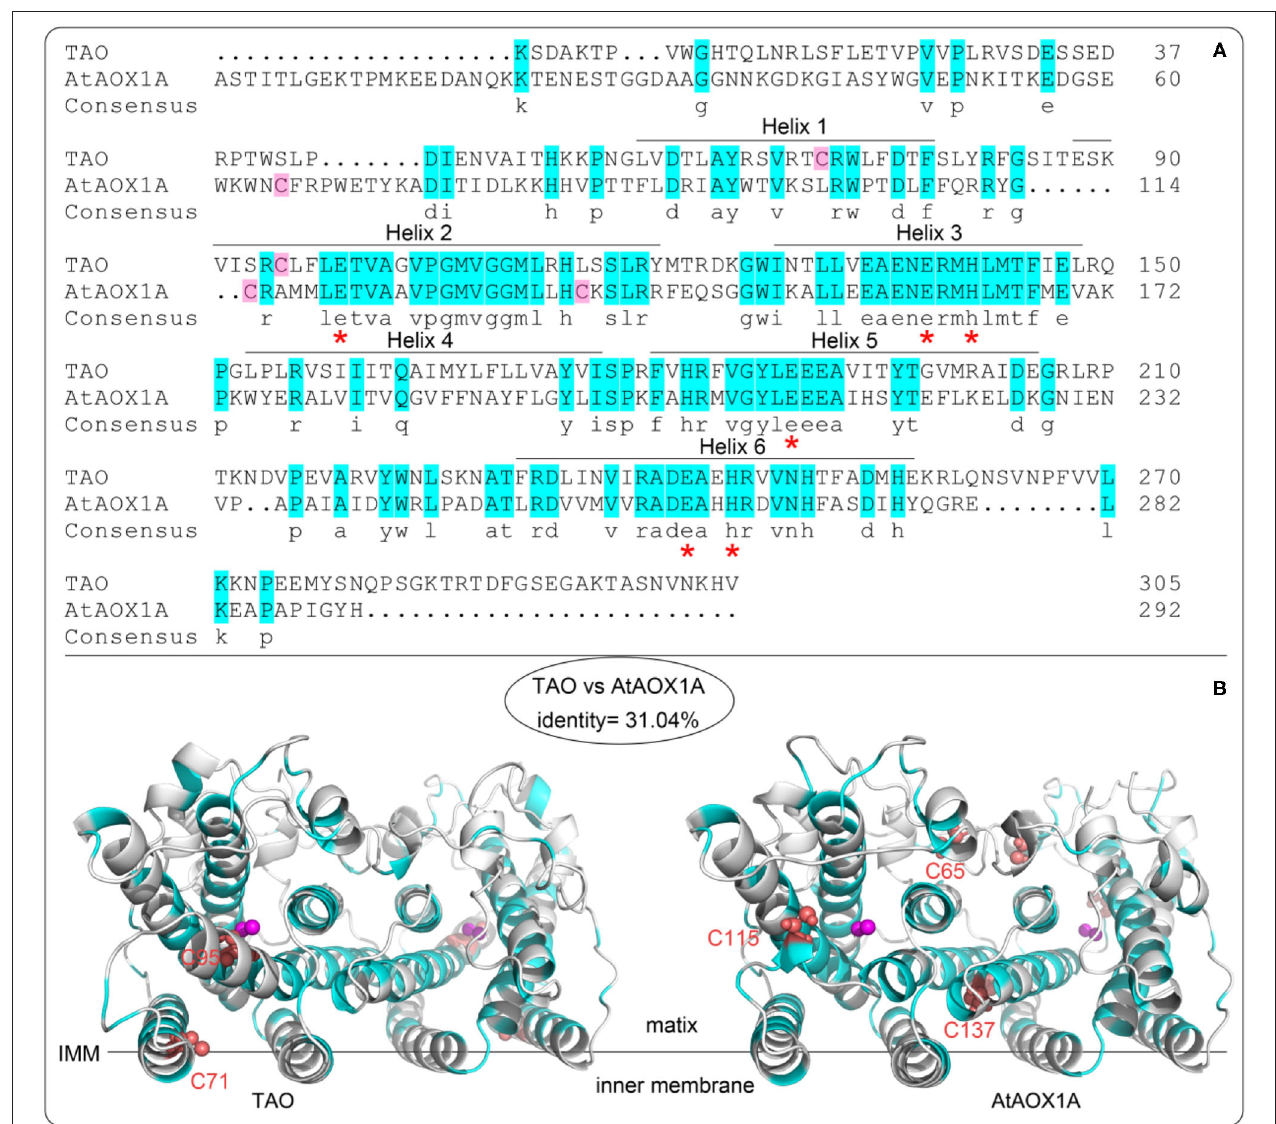
FIGURE 2 | Alignment of protein sequences and homology structure of TAO and AtAOX1A. (A) Aminol acid sequence alignments between TAO and AtAOX1A without leading sequences. The blue background shows similar amino acids between TAO and AtAOX1A. Asterisks (red) represent the conserved amino acid residues binding to di-iron ferroxidase centers. The pink background shows the cysteine contained in AOXs. (B) Comparison of cysteine sites based on the secondary structure of TAO and AtAOX1A. Purple sphere shows di-iron center. The red sphere shows cysteine position. IMM, inner mitochondrial